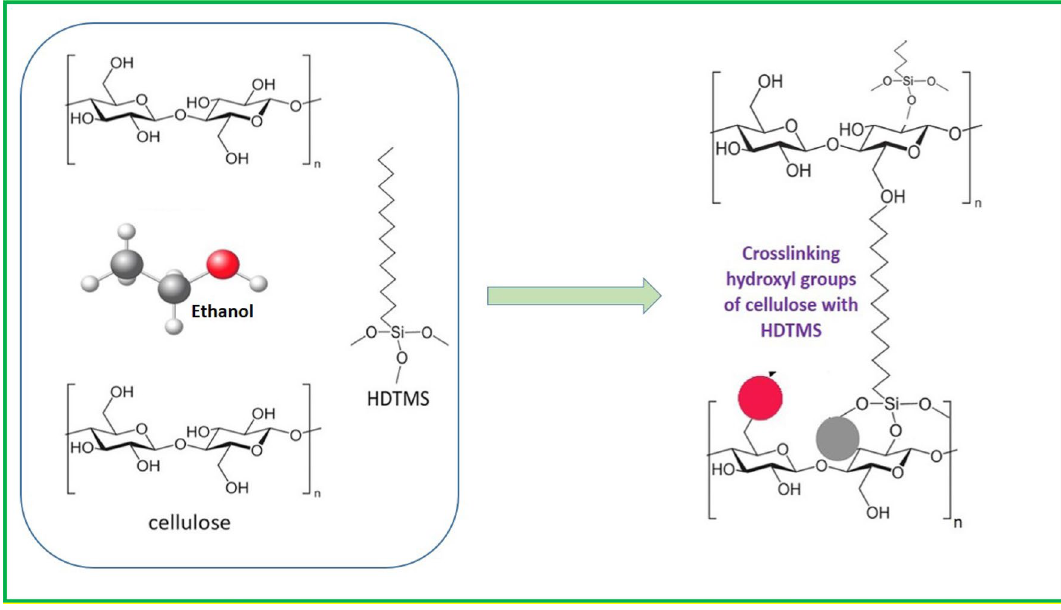
Fig. 3 Possible formation and fixation mechanism of hexadecyltrimethoxysilane (HDTMS) on nonwoven cotton